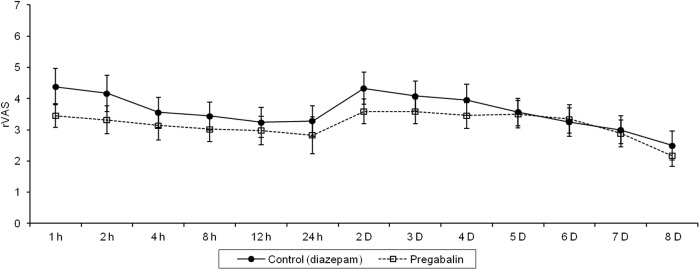
Visual analogue scale scores during rest (rVAS) after tonsillectomy in the control and pregabalin groups.Results are expressed as the mean score ± standard error (vertical bars represent standard error). There were no significant differences in the pain score between the two groups throughout the postoperative period. Abbreviation h: hour, D: day.